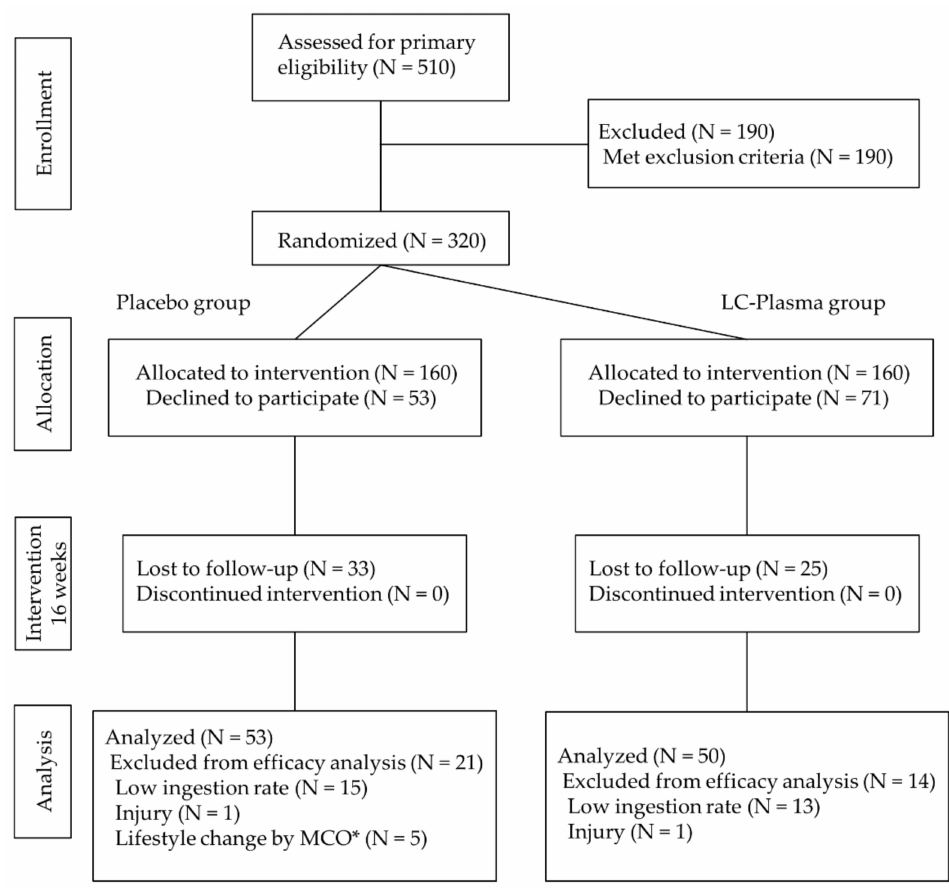
Figure 1. Flow chart diagram of this trial. * MCO, movement control order, implemented by the Malaysian government due to the COVID-19